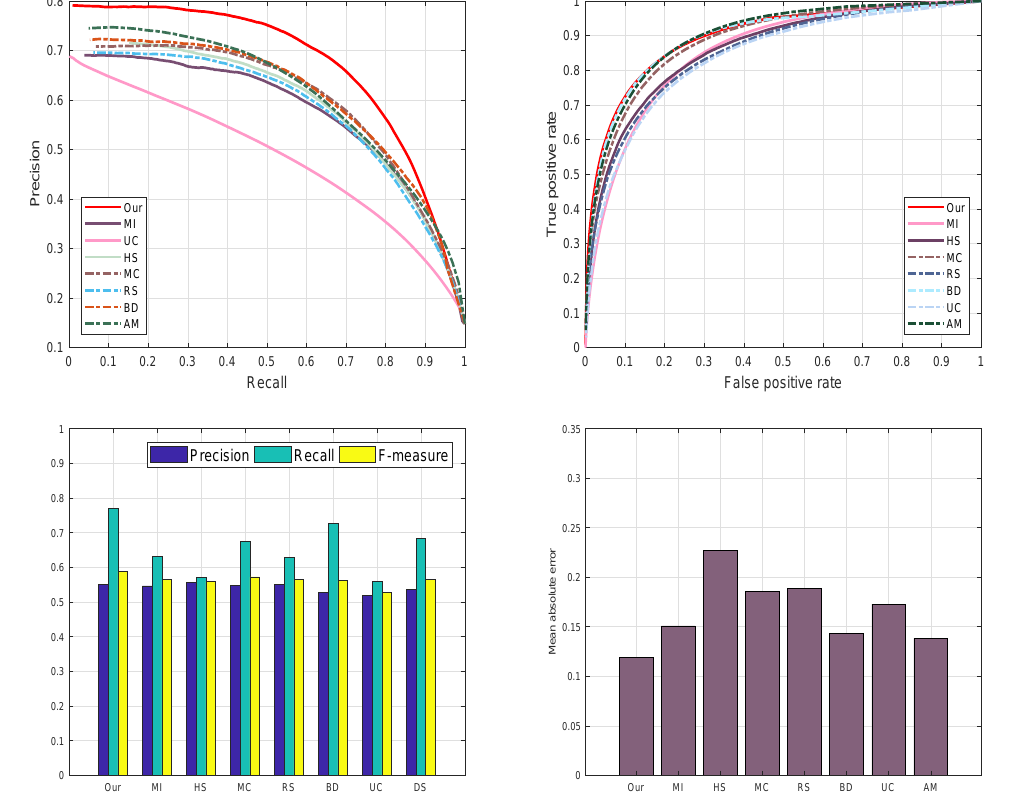
Figure 11. The graphical evaluation of our method with seven current approaches such as AM [29], BD [42], RS [43], MC [44], MI [30], HS [39], UC [31] and our proposed model on the DUT-OMRON